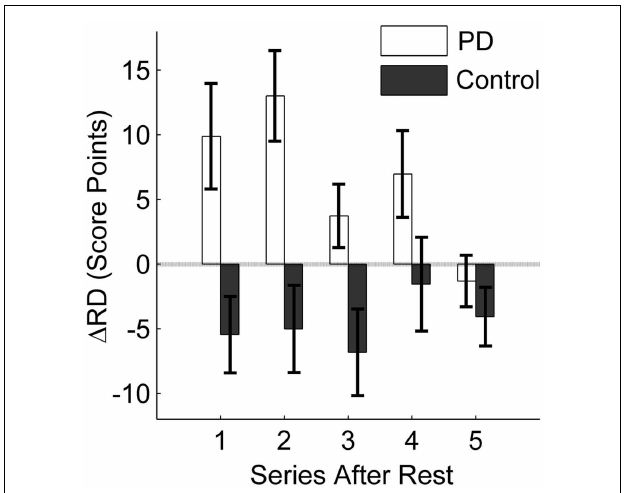
FIGURE 5 | Influence of initiation intervention on retention. The difference between retention with intervention and without intervention is displayed.The average difference in score points for the first five series after rest (10 trials each) is displayed for the PD patients and the control group. Positive values indicate a positive effect of the intervention on retention; negative values result when the intervention leads to poorer retention as compared to no intervention. Error bars denote the standard error of the mean.